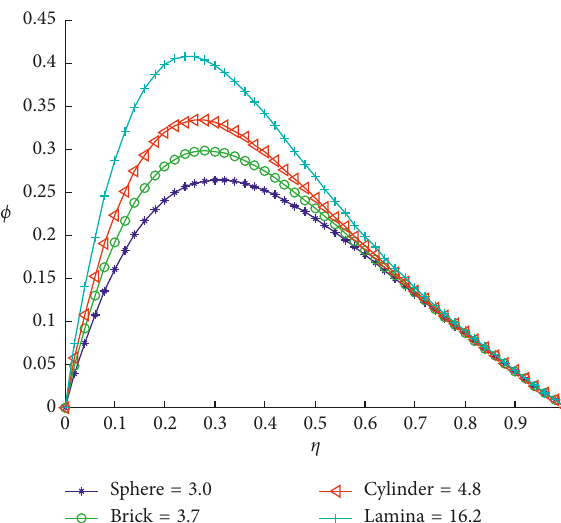
Figure 20: Effect of the nanoparticle shape factor on the con- Nb centration profile when A 2 , S 1 ,Nt 0 . 2 , β 0 . 05 ,M (cid:31) (cid:31) (cid:31) (cid:31) (cid:31) Pr 0 . 5 ,Le 1 . 0 , c 0 . 1 , and C (cid:31) (cid:31) (cid:31)